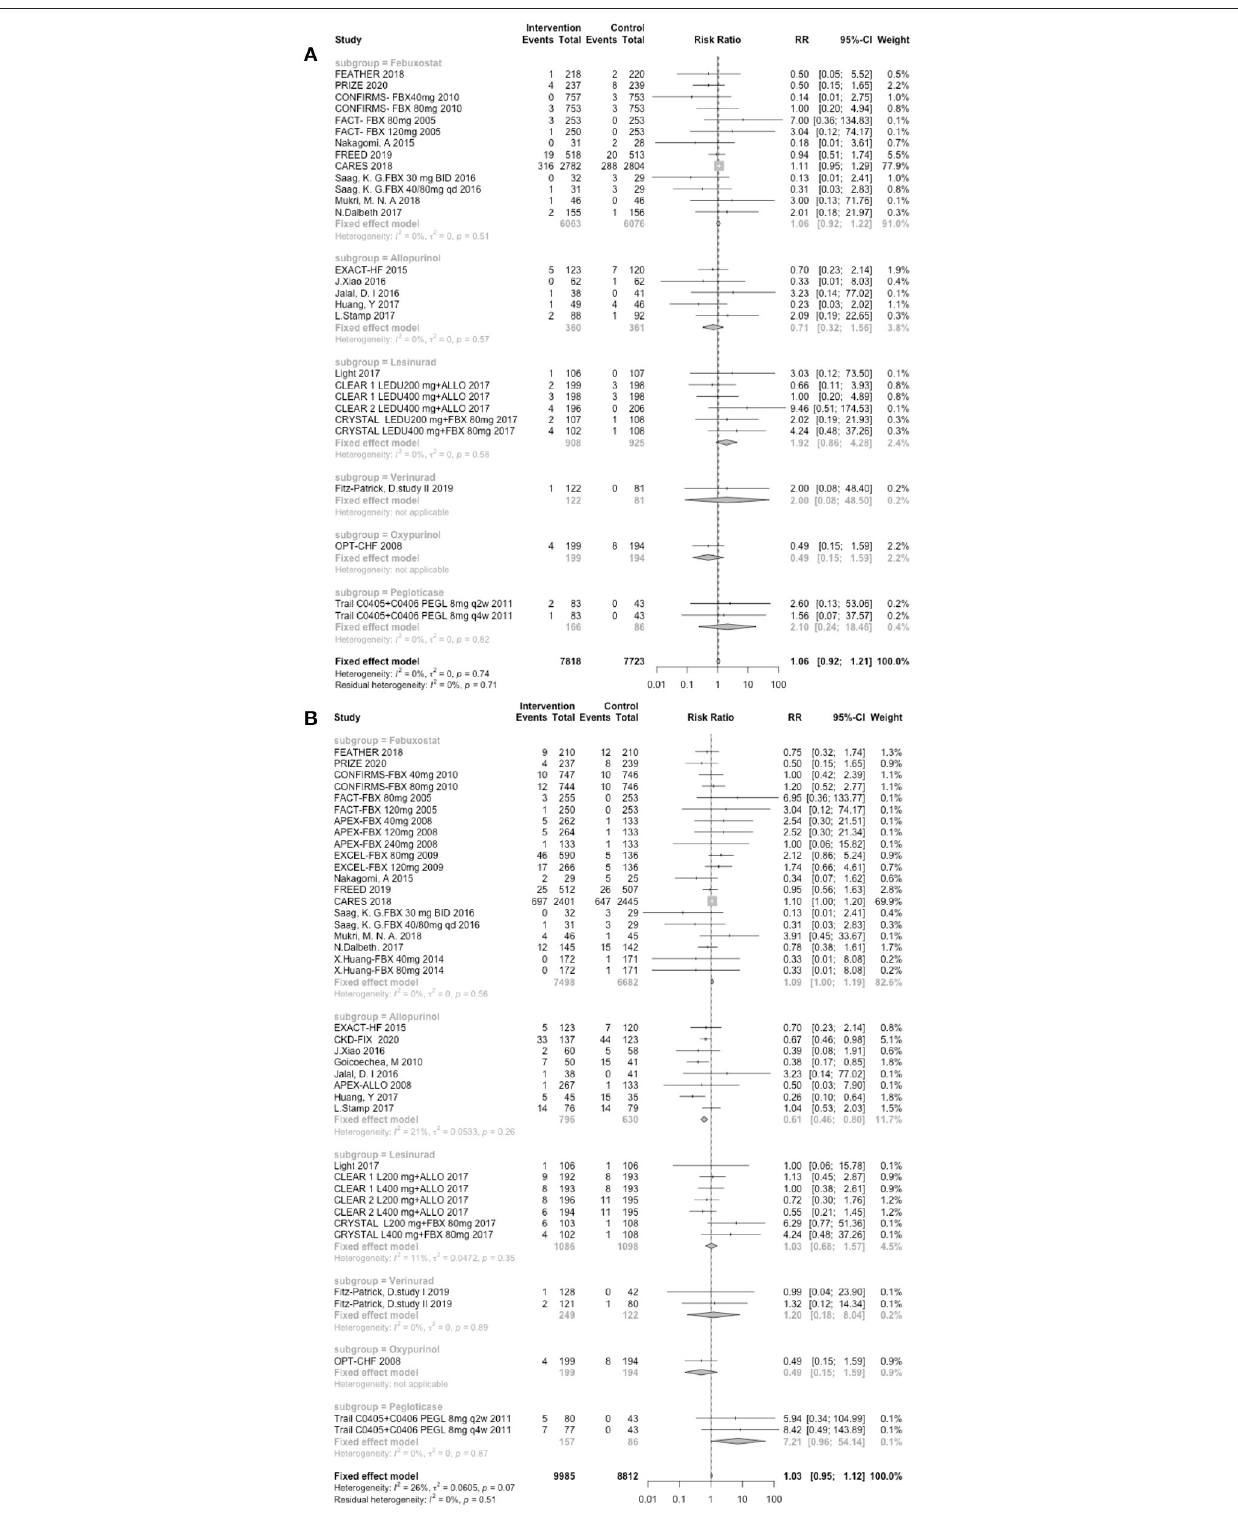
FIGURE 3 | Assessment of cardiovascular outcomes. (A) Forest plots depicting the incidence of MACEs. (B) Forest plots depicting the incidence of CVEs. RR indicates risk ratio; CI indicates confidence interval.